Question: What form of chart is displayed?
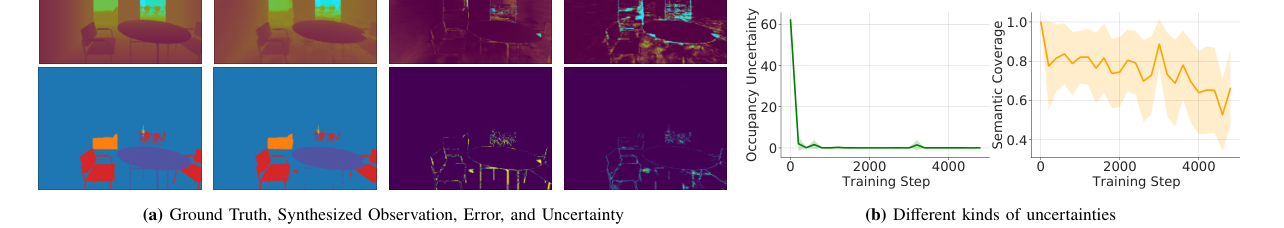
Answer: bar